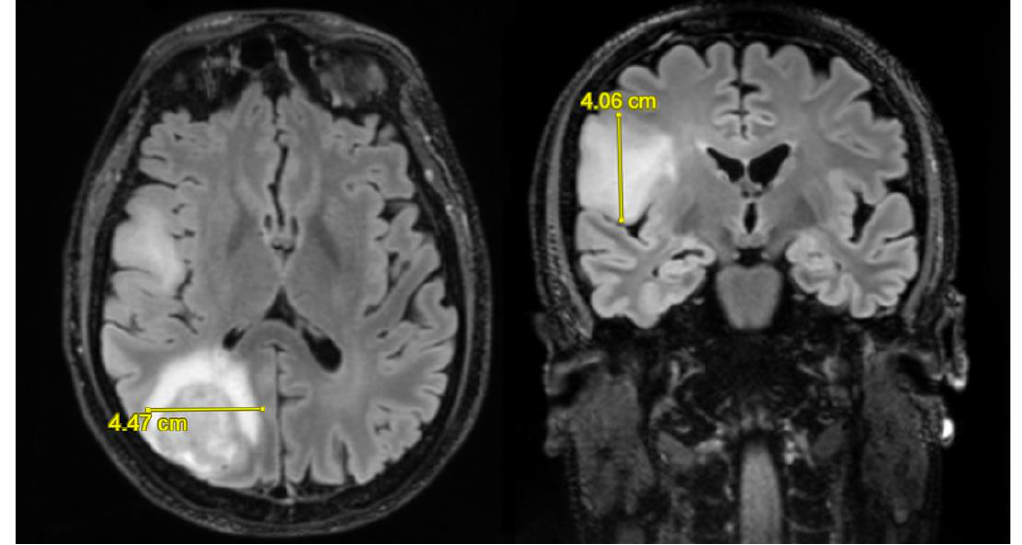
Figure 2. Axial and coronal FLAIR MR images with measurement of the latero-lateral and cranio- caudal diameters of the GBM.